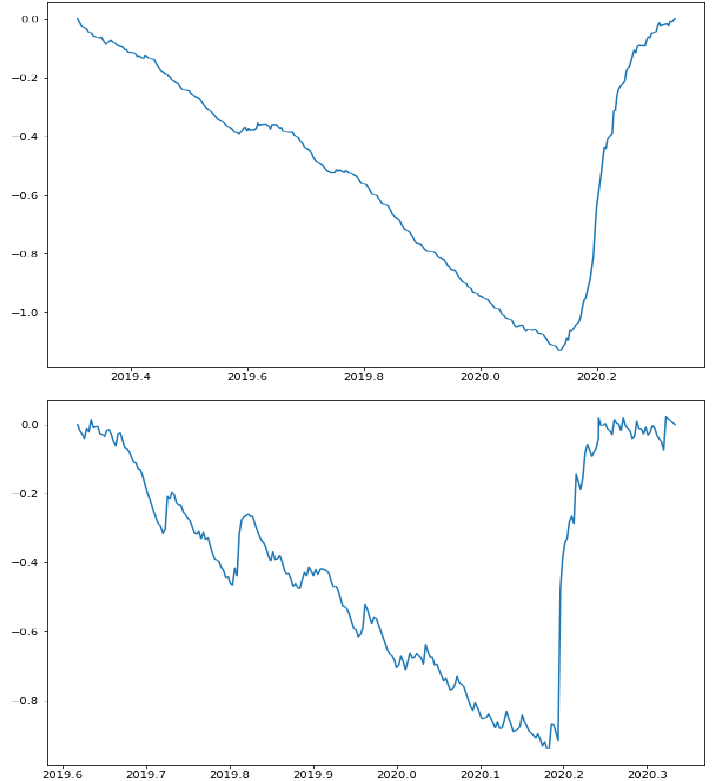
Figure 1. The picture at the top depicts the volatility series of the S&P500 index in the period ranging from March 2019 to March 2020. A self-similarity exponent equal to 0.94 is obtained by the FD4 approach. The graph below illustrates the volatility series of the Bitcoin/USD index in a similar period (both series contain 250 data (one year of trading), but recall that the Bitcoin/USD currency remains active also on weekends). In that case, a self-similarity exponent equal to 0.65 is